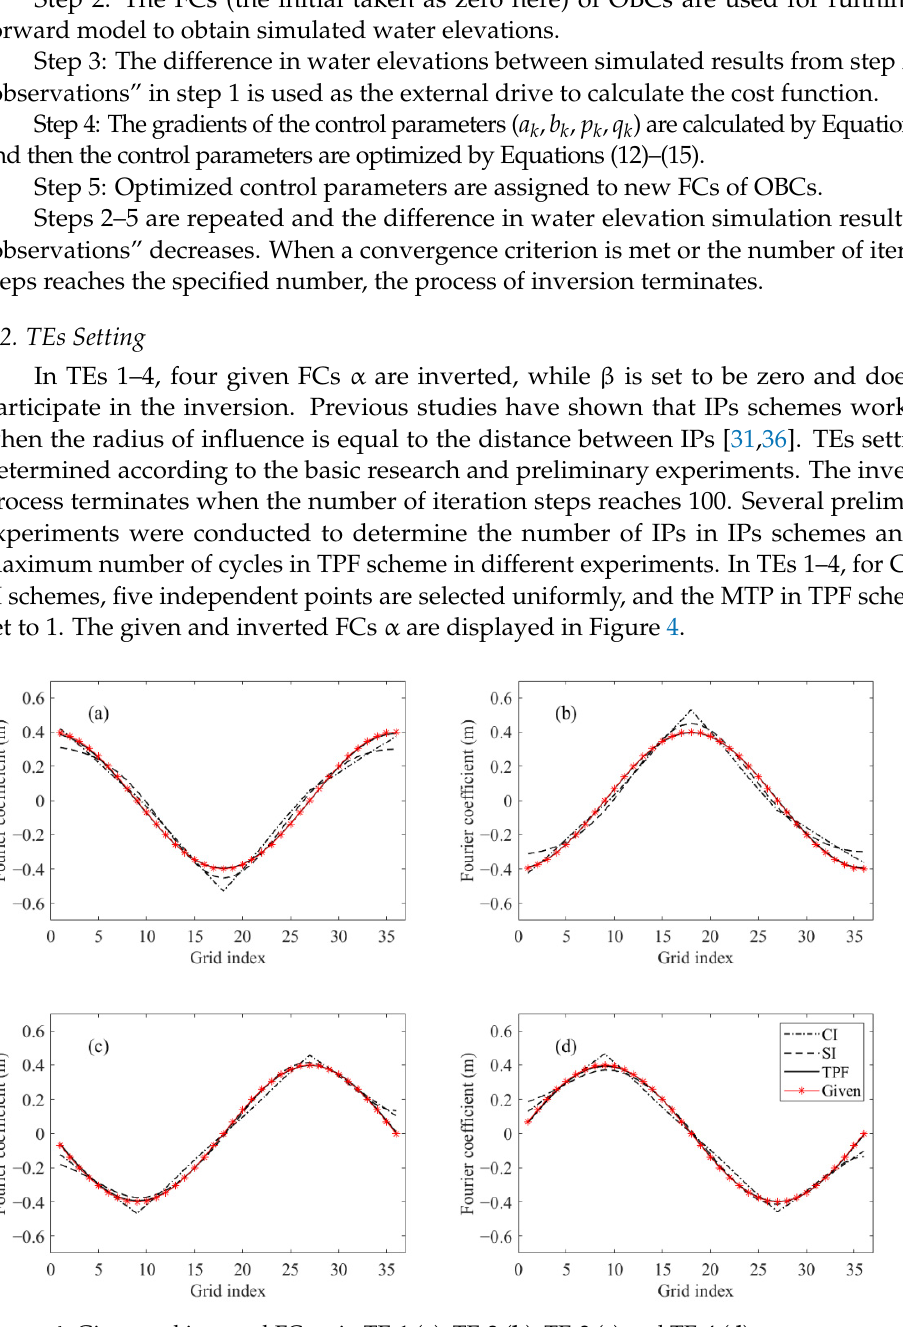
Figure 4. Given and inverted FCs α in TE-1 ( a ), TE-2 ( b ), TE-3 ( c ) and TE-4 ( d